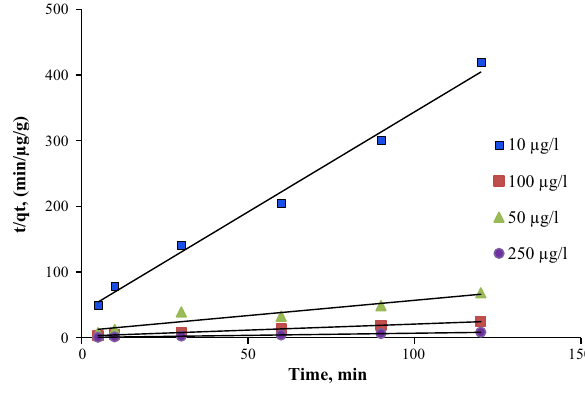
Fig. 5 Pseudo-second-order kinetic plots for arsenic adsorption onto modified saxaul Concentration Pseudo-first-order arsenic (µg/L)